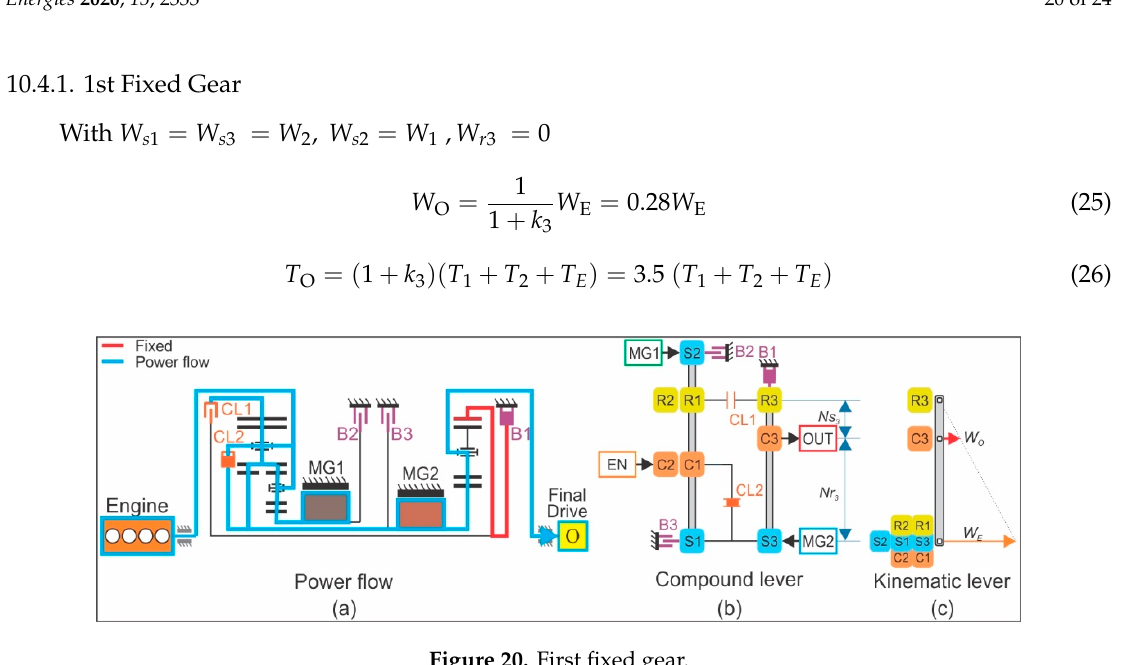
Figure 20. First fixed gear.